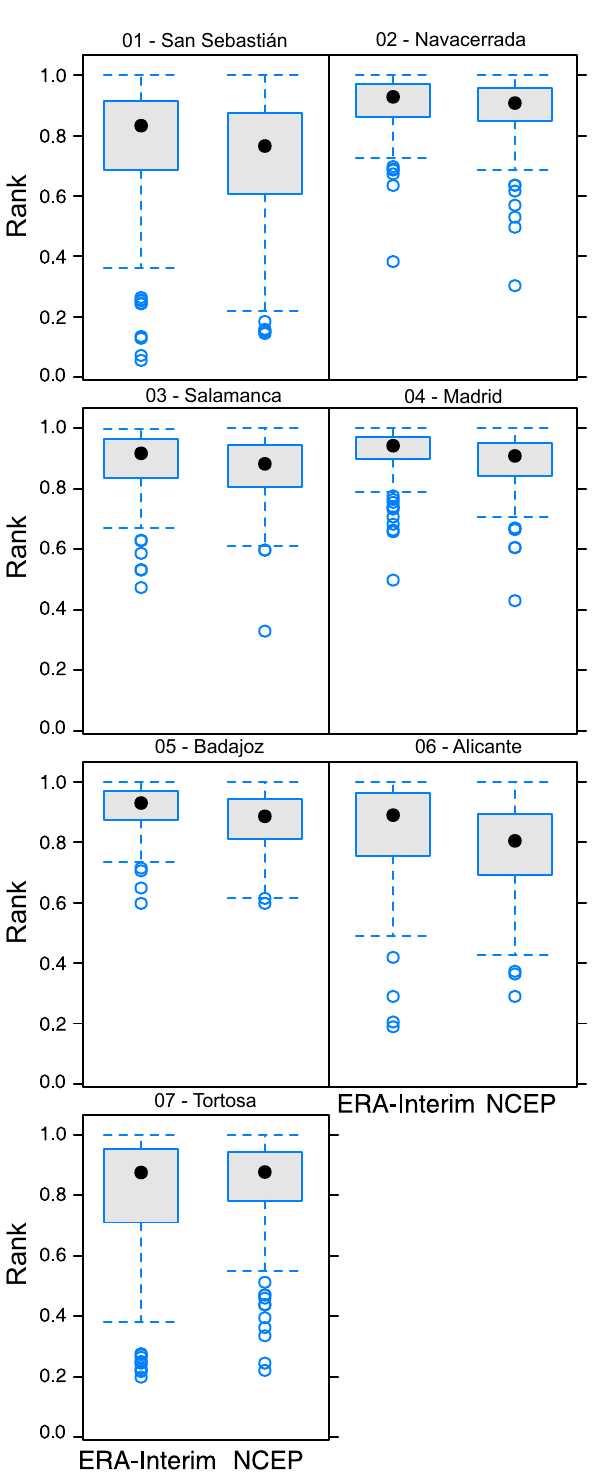
Fig. 5. Rank boxplots of observed FWI quantiles corresponding to the reanalysis (ERA-Interim and NCEP) extreme fire danger events (values above FWI90).